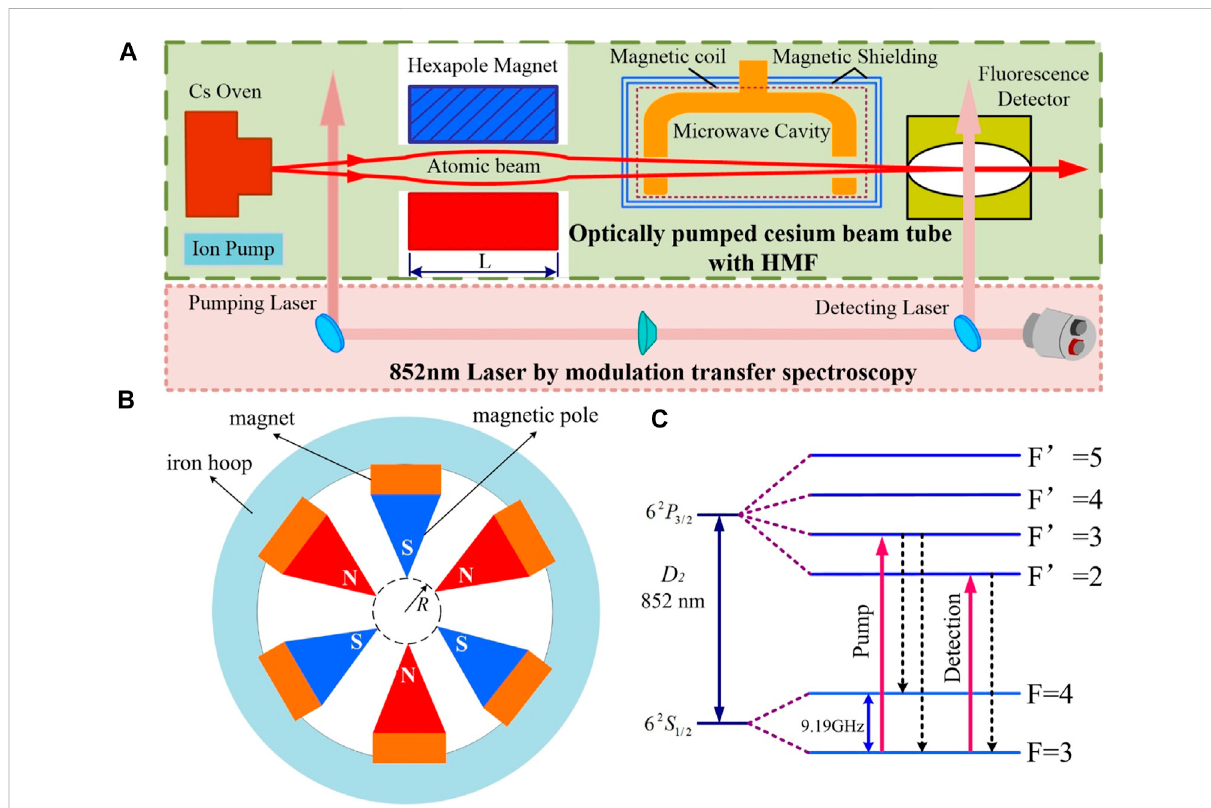
FIGURE 4 EnergylevelsandoverallapproachofOPCBTbasedonHMF. (A) ThegreenboxisthediagramofOPCBTwith HMFsystem, Listhelength ofthe hexa-polemagnets.Thepinkboxisthe852 nmlaserbyMTS. (B) Thecross-sectionoftheHMFsystem,Ristheboreradiusofthehexa-polemagnets. (C) Relevant energy levels of cesium, |F = 3 > → |F ’ = 2 > is cycling